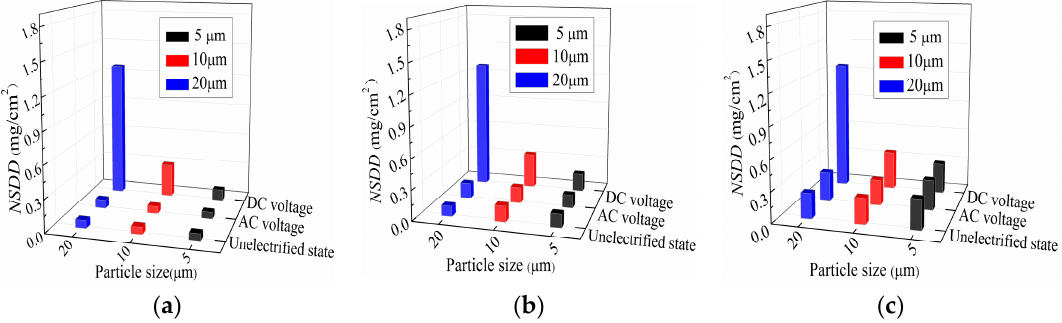
Figure 6. NSDD of the porcelain three-umbrella insulator, ( a ) v = 3 m/s; ( b ) v = 5 m/s; and ( c ) v = 7 m/s.